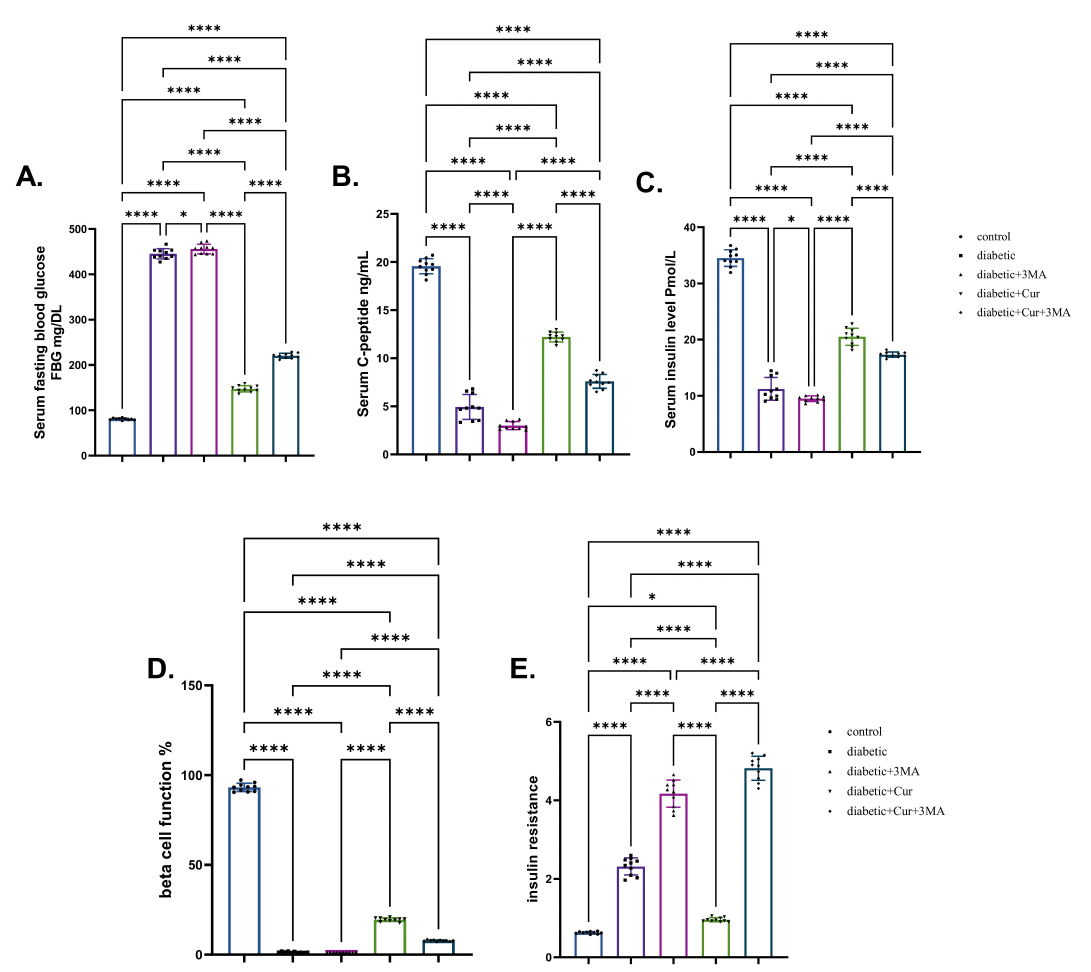
Figure 2. Effect of diabetes (STZ) (65 mg/kg b.wt), 3MA (10 mg/kg b.wt), LPs-CUR (10 mg/kg b.wt.) oral dosing for 10 weeks on ( A ) serum blood glucose, ( B ) C-Peptide, ( C ) Serum insulin, ( D ) Beta cell function %, ( E ) insulin resistance. Data expressed as mean ± SE, n = 10 for each group. Each bar carrying the significance which may be significant at * means when p < 0.05, and **** p <